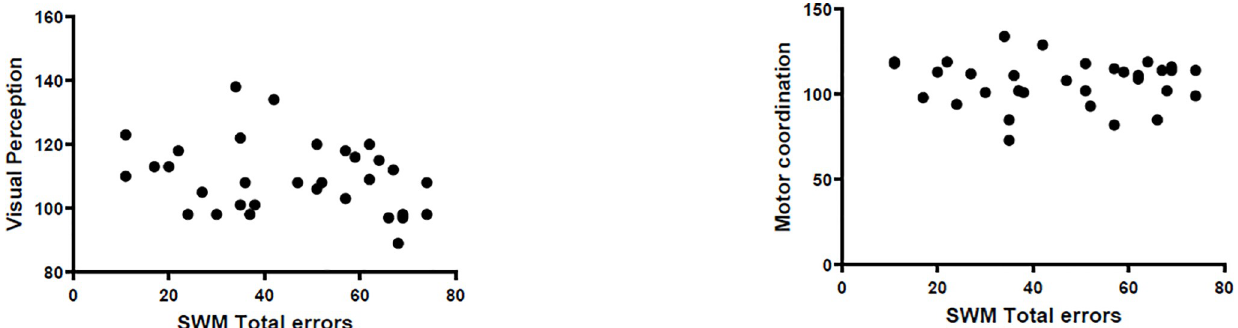
Fig 2. Scatter diagrams of Spatial Working Memory and VMI performances in typically developing children. The Pearson correlation analyses were conducted with age and IQ as covariant. The left picture showed the correlation between spatial working memory and visual perception was not significant (r = -0.214, p = 0.256). The right picture showed the correlation between spatial working memory and motor coordination was not significant (r = 0.099, p = 0.604).